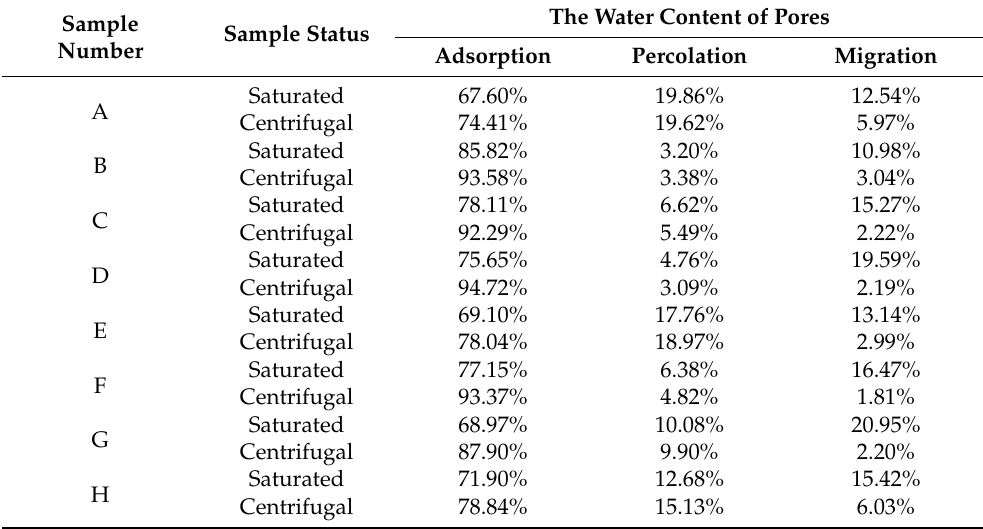
Table 2. Percentage of water content before and after